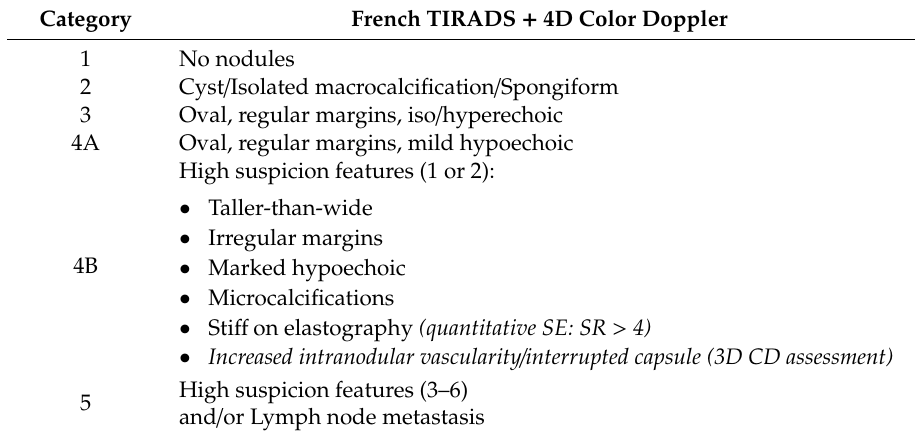
Table 3. Proposed algorithm for US classification of thyroid nodules, including Volumetric Color Doppler evaluation. Adapted from French TI-RADS, Russ, 2016